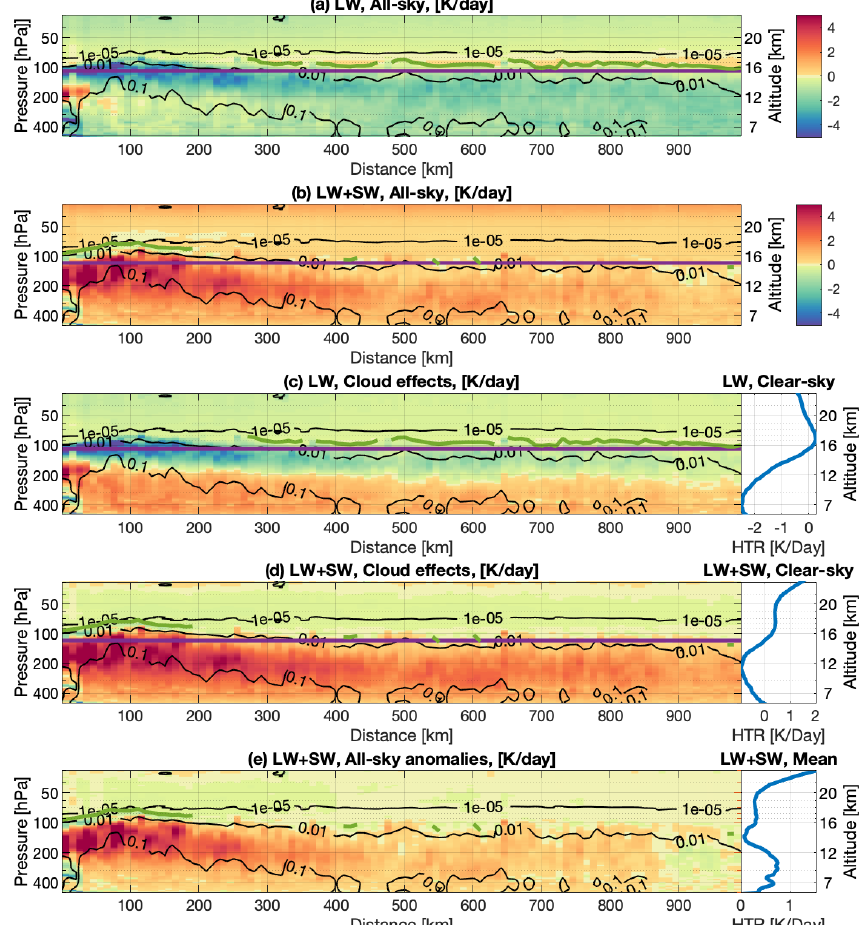
Figure 11. Radiative heating (shading, K/d, from CloudSat 2B-FLXHR-LIDAR) and IWC (black contour, g/m 3 , from DARDAR-Cloud) as a function of distance to the cyclone center. (a) All-sky longwave and (b) net (longwave + shortwave) radiative heating rates. (c, d) The same as (a, b) but for cloud radiative effects, which are defined as the differences between all-sky heating rates and the mean clear-sky heating rate (blue curve in the right panel). (e) The same as (d) but for all-sky net radiative heating anomalies, which are defined as the differences between all-sky heating rates and the mean all-sky heating rate. The magenta line marks the clear-sky LZRH. The green line marks the cloudy-sky LZRH, determined as the vertical position where the heating rate changes from positive to